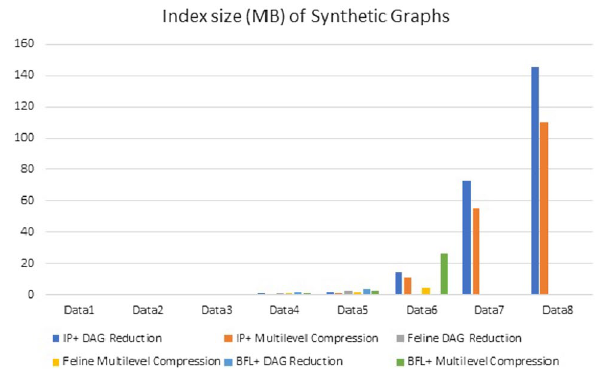
Fig. 8 Index size (MB) comparison for IP + , Feline and BFL +